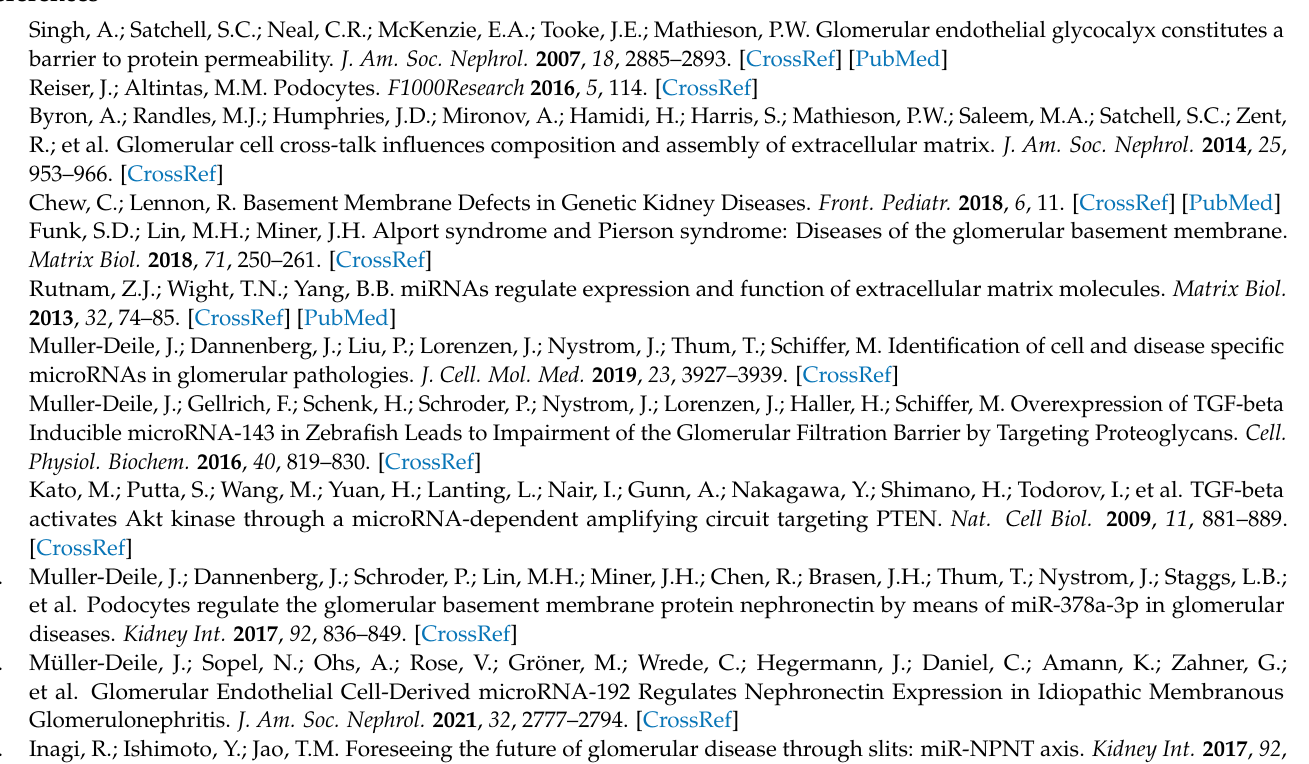
Figure S2: NPNT expression in wild type podocytes as well as in the Smad2/3 double-deficient podocytes after stimulation with TGF- β